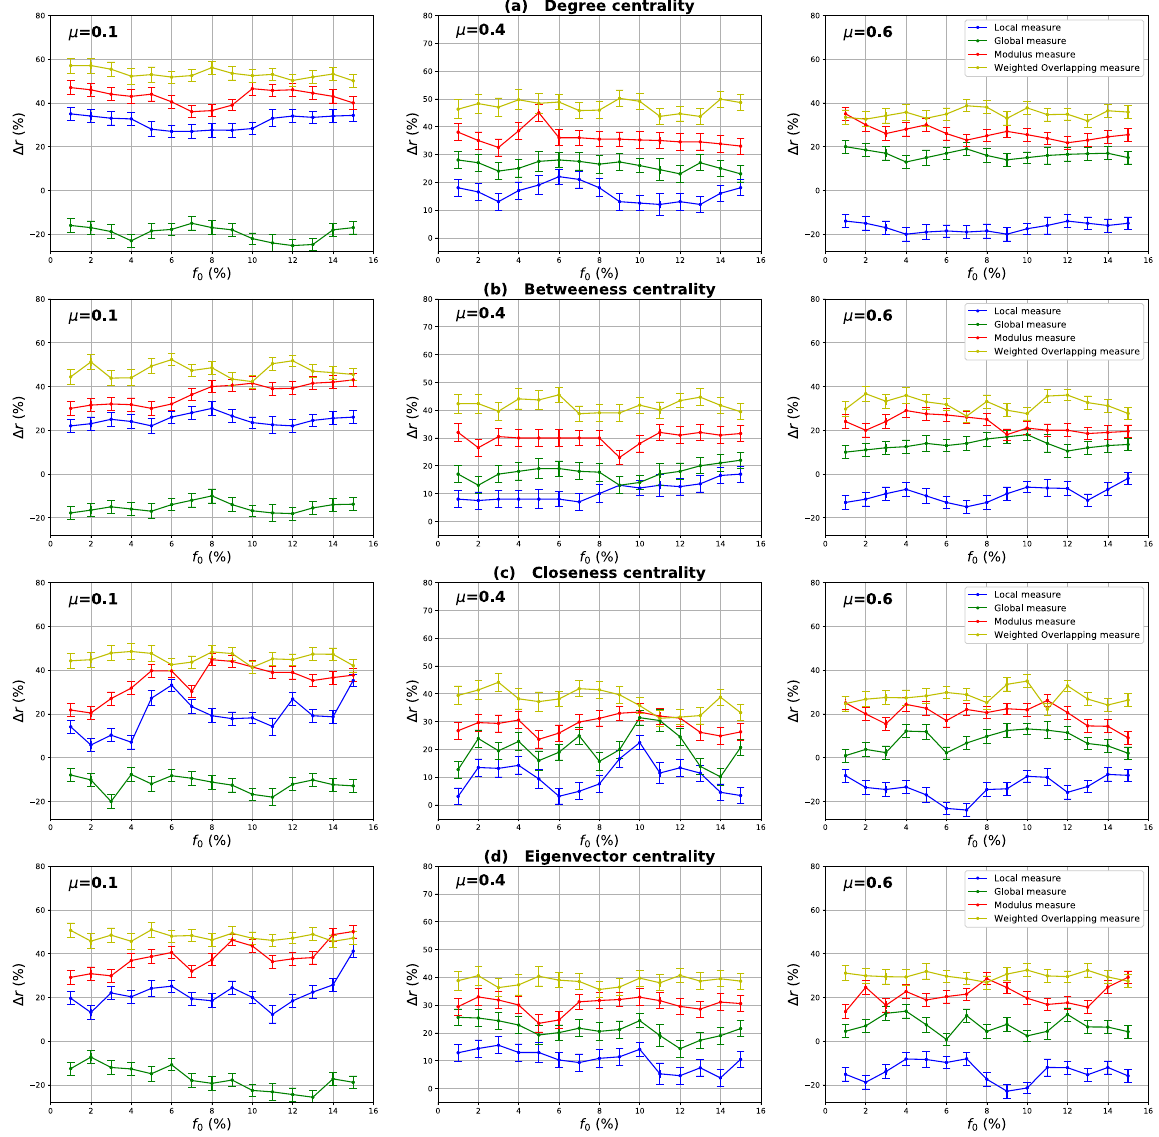
Figure 3. Relative difference of the outbreak size Δ r versus the percentage of initial spreaders f 0 , where Δ = − r R R R ( / ) , R c and R s are the final number of recovered nodes for the centrality measure under test and c s s the standard centrality, respectively. The Degree ( a ), Betweenness ( b ), Closeness ( c ) and Eigenvector ( d ) centrality measures are compared to their extensions derived from the Overlapping Modular Centrality. Synthetic networks generated by the LFR algorithm with different community structure strength are used (the value of their mixing coefficient is equal to 0.1, 0.4 and 0.6). We set the proportion of overlapping nodes on to 10% of the size of the network and the community membership om to 10% of the total number of communities. Each value on the curves is obtained by averaging the results of 200 SIR simulations per method and fraction of initially infected nodes. Δ r is positive if the centrality under test is more effective than the standard